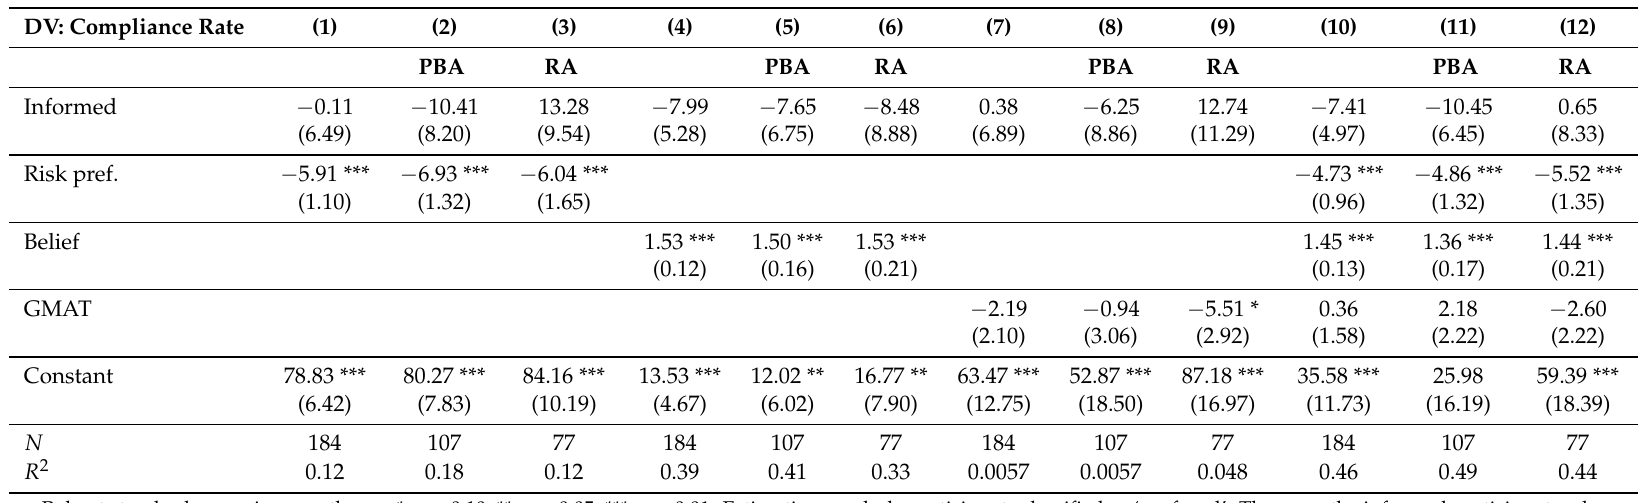
Table A4. Information treatment regressions (OLS) with covariates—excluding